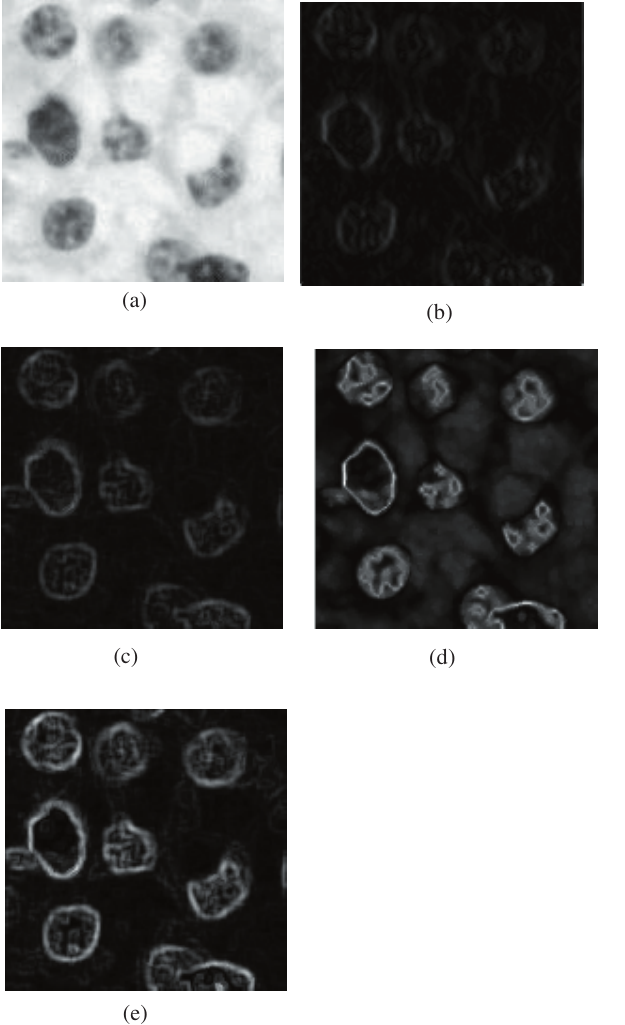
Fig. 6. : a) blood cell image, b) edge image using fuzzy morphology, c) edge image using the interval valued fuzzy set, d) edge image by Chaira and Ray , e) edge image using proposed